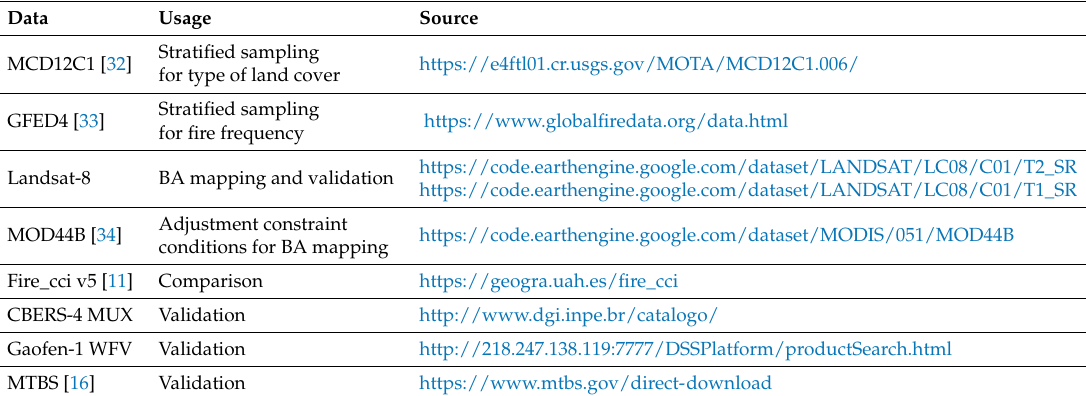
Table 1. Description of data sources. GFED, Global Fire Emissions Database; BA, Burned Area; MTBS, Monitoring Trends in Burn Severity.